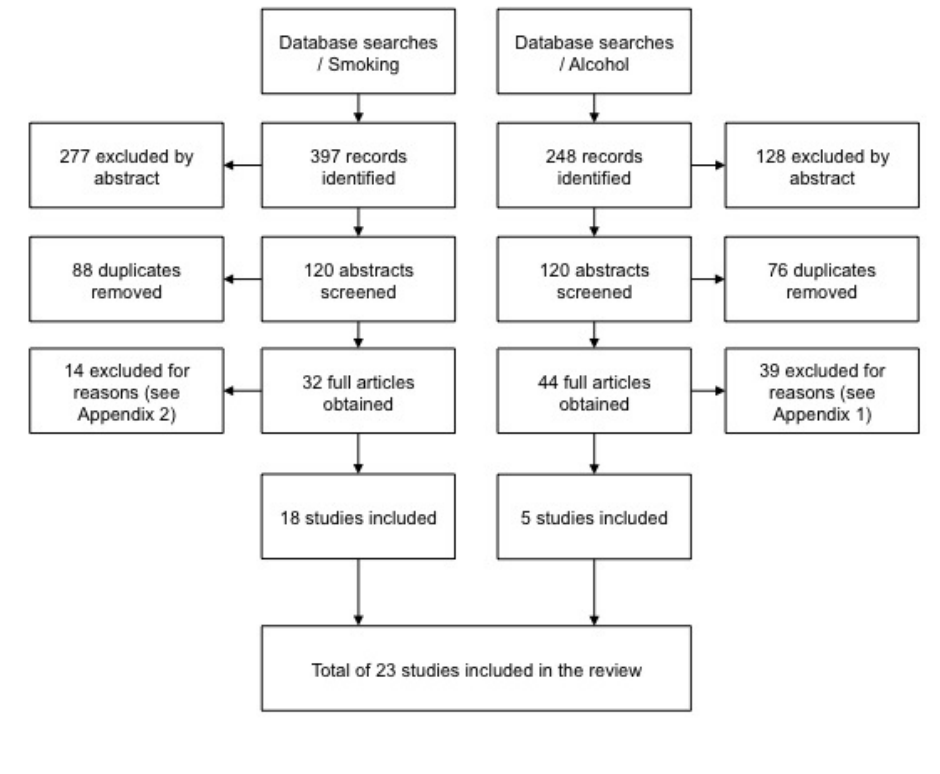
Figure 1. Study identification